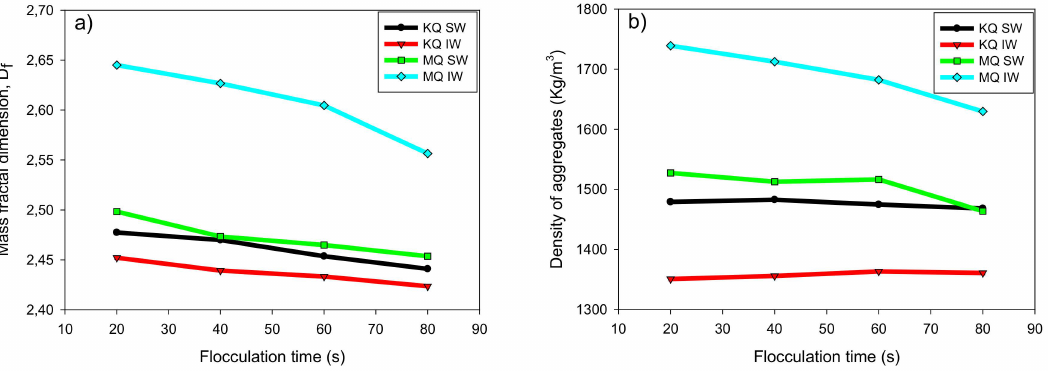
Figure 9. Fractal dimension ( a ) and density of aggregates ( b ) for KQ and MQ tailings in SW and IW. Flocculant dose 34 g/t, solids concentration 8 wt% (clay/quartz 10/90), mixing rate 180 rpm and pH